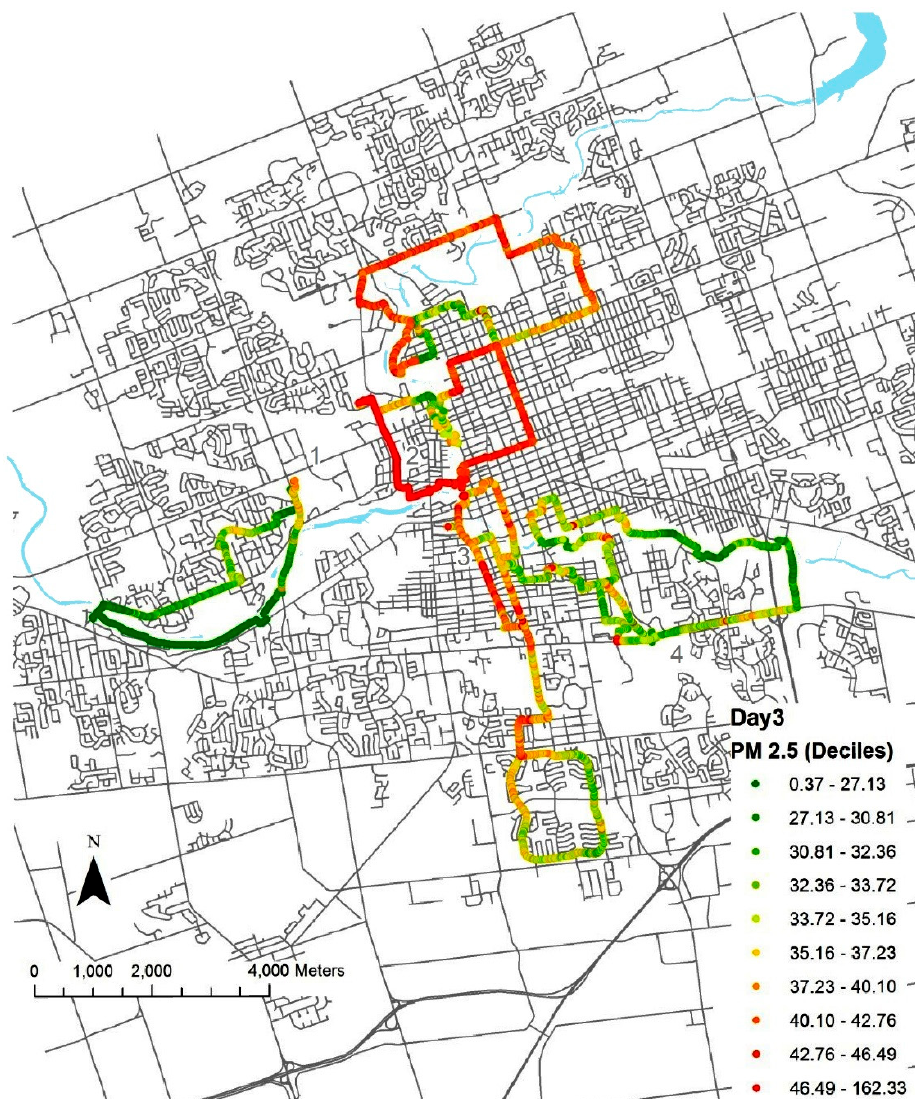
Figure 3. PM 2.5 concentrations from a typical day labeled by decile. PM 2.5 levels are generally distributed unevenly along the cycled routes, with the higher personal exposure concentrations in the urban core and lower concentrations extending out into the suburbs. All measurements in µg/m 3 .